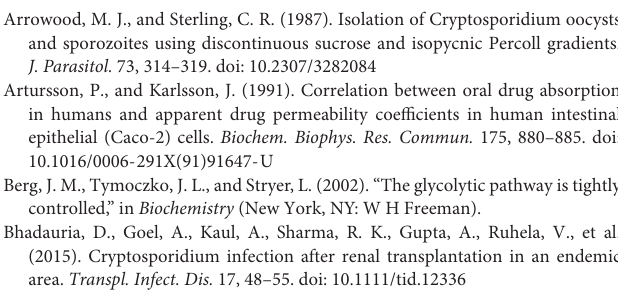
Supplementary Figure 1 | A representative standard curve generated by the 7500-system software for quantification of C. parvum oocyst load in mice fecal